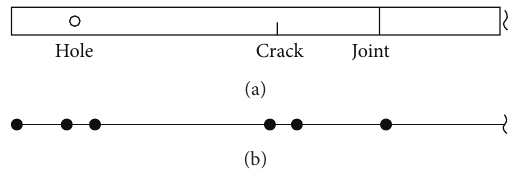
Figure 1: Actual structure representation (a) and spectral element model representation